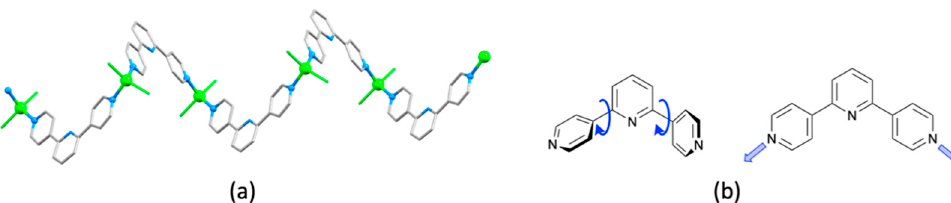
Figure 11. ( a ) Part of the 1D-chain in [Zn(4,2 (cid:48) :6 (cid:48) ,4 (cid:48)(cid:48) -tpy)Cl 2 ] n (CSD refcode GAQYUS). ( b ) Rotation about the inter-ring C–C Figure 11. (a) Part of the 1D ‐ chain in [Zn(4,2’:6’,4” ‐ tpy)Cl 2 ] n (CSD refcode GAQYUS). (b) Rotation about the inter ‐ ring C– C bonds does not change the vectorial properties of the ditopic 4,2’:6’,4” ‐ tpy metal ‐ binding domain. bonds does not change the vectorial properties of the ditopic 4,2 (cid:48) :6 (cid:48) ,4 (cid:48)(cid:48) -tpy metal-binding domain. Table 1. 1D ‐ coordination polymers of general formula [Zn(4’ ‐ X ‐ 4,2’:6’,4” ‐ tpy)Cl 2 ] n . Table 1. 1D-coordination polymers of general formula [Zn(4 (cid:48) -X-4,2 (cid:48) :6 (cid:48) ,4 (cid:48)(cid:48) -tpy)Cl 2 ] n . Compound CSD Refcode Space Group N–Zn–N/ ◦ Zn . . . Zn/Å